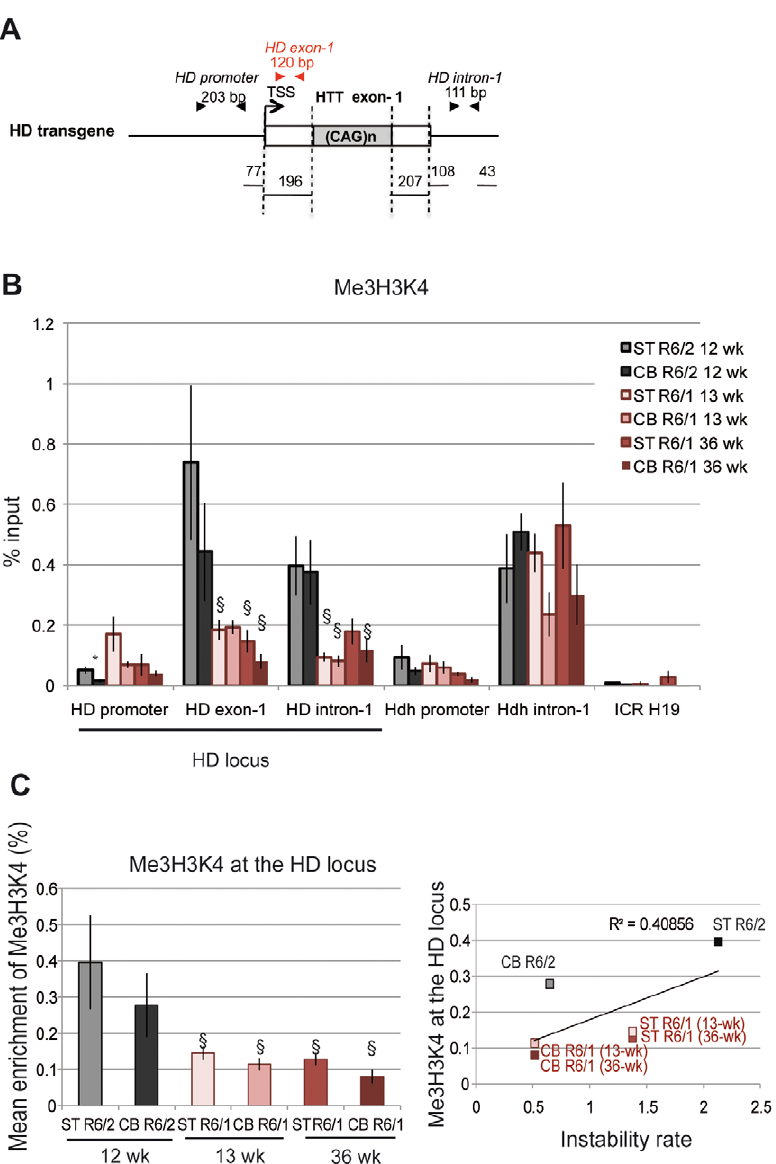
Figure 4. Me3H3K4 at the HD locus in R6/1 and R6/2 striatum and cerebellum. A. Schematic representation of the HD transgene expressed in R6 mice, showing location of primers used to amplify the region just downstream of the TSS in HD exon-1. B. ChIP analyses from the striatum and the cerebellum of R6/1 mice at 13- and 36-wk and from the striatum and cerebellum of R6/2 mice at 12-wk, using antibody to Me3H3K4. Error bars, sem; *, inter-tissue comparisons; 1 , inter-mouse line comparisons. *, p , 0.05; 1 , p , 0.05. C. Left panel. Global analysis of the level of Me3H3K4 at the HD locus. Me3H3K4 levels at the HD locus correspond to mean ChIP values at the HD promoter, HD exon-1 and HD intron-1. Error bars, sem; 1 , p , 0.05. Right panel. Correlative analysis of CAG instability rates and Me3H3K4 levels at the HD locus. R6/1 mice of 13 and 36 weeks and R6/2 mice of 12 weeks were used for correlation analysis.